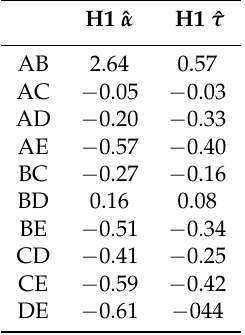
Table 2. Estimates of association with right